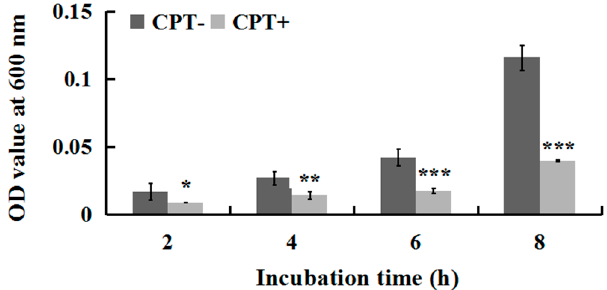
Figure 2. Effect of incubation time on the antibacterial activity of CPT against Acidovorax avenae subsp. avenae strain RS-2. The concentration of CPT is 0.50 mg/mL. *: p < 0.05; **: p < 0.01; ***: p < 0.001. Error bars represent the standard error of the mean ( n = 6). Data are from a representative experiment repeated twice with similar results.